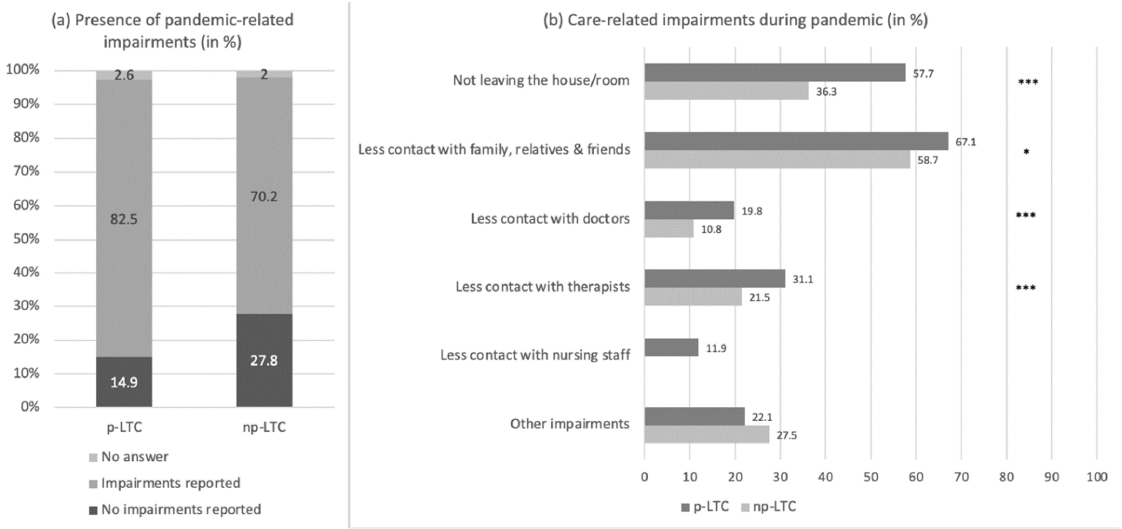
Figure 2. Specific care-related impairments during COVID-19 pandemic (in %). ( a ) Percentage of people with Parkinson’s disease (PwP) with or without COVID-19 pandemic-related impairments are shown for both groups with (p-LTC) and without (np-LTC) professional care. ( b ) Percentage of PwP reporting about certain care-related impairments: p-LTC = dark grey, np-LTC = light grey. Significant group differences are marked: * p < 0.05, *** p < 0.001. Multiple answers were allowed here. PwP of both groups who indicated negative pandemic-related impact (p-LTC: 82.5%, np-LTC: 70.2%, see right graph (b)) also reported contact limitation with family, relatives, and friends as the major impairment, which was followed by limited options to leave the house or apartment. Interestingly, reduced contacts with doctors or nursing staff were only rarely mentioned. Again, most restrictions (leaving house, less contact with families, doctors, and therapists) were significantly more pronounced in the p-LTC group. The per- centage of “other” impairments was comparable in both groups, with free text answers specifying limitations such as reduced social contacts in general, decreased cultural offer- ings, limited access to gastronomy, less physical activity (e.g., sports or swimming groups), or restricted interchange in the PD support groups. 3.3. Sanitary Measures during Professional Care Sessions in the p-LTC Group Regarding sanitary measures during professional care sessions, as can be seen in Fig- ure 3, results show that in the p-LTC group the best implemented measure was the nurs- ing staff wearing masks (85.1%), followed by hand hygiene (68%) and room ventilation (66.5%), whereas the PwPs’ protection measures only played a minor role, with just 23.4% of them wearing a mask. A total of 8.6% of PwP reported to not even know about the sanitary measures ap- plied. The term “others” was mainly specified with vaccination, measuring temperature of visitors in long-term care facilities, wearing gloves, and avoiding unnecessary contacts. Furthermore, the p-LTC group felt only moderately protected by (mean 6.9 (0–10) ± SD 2.9) and informed about (mean 5.3 (0–10) ± SD 3.5) their nursing staffs’ sanitary measures’ concepts.